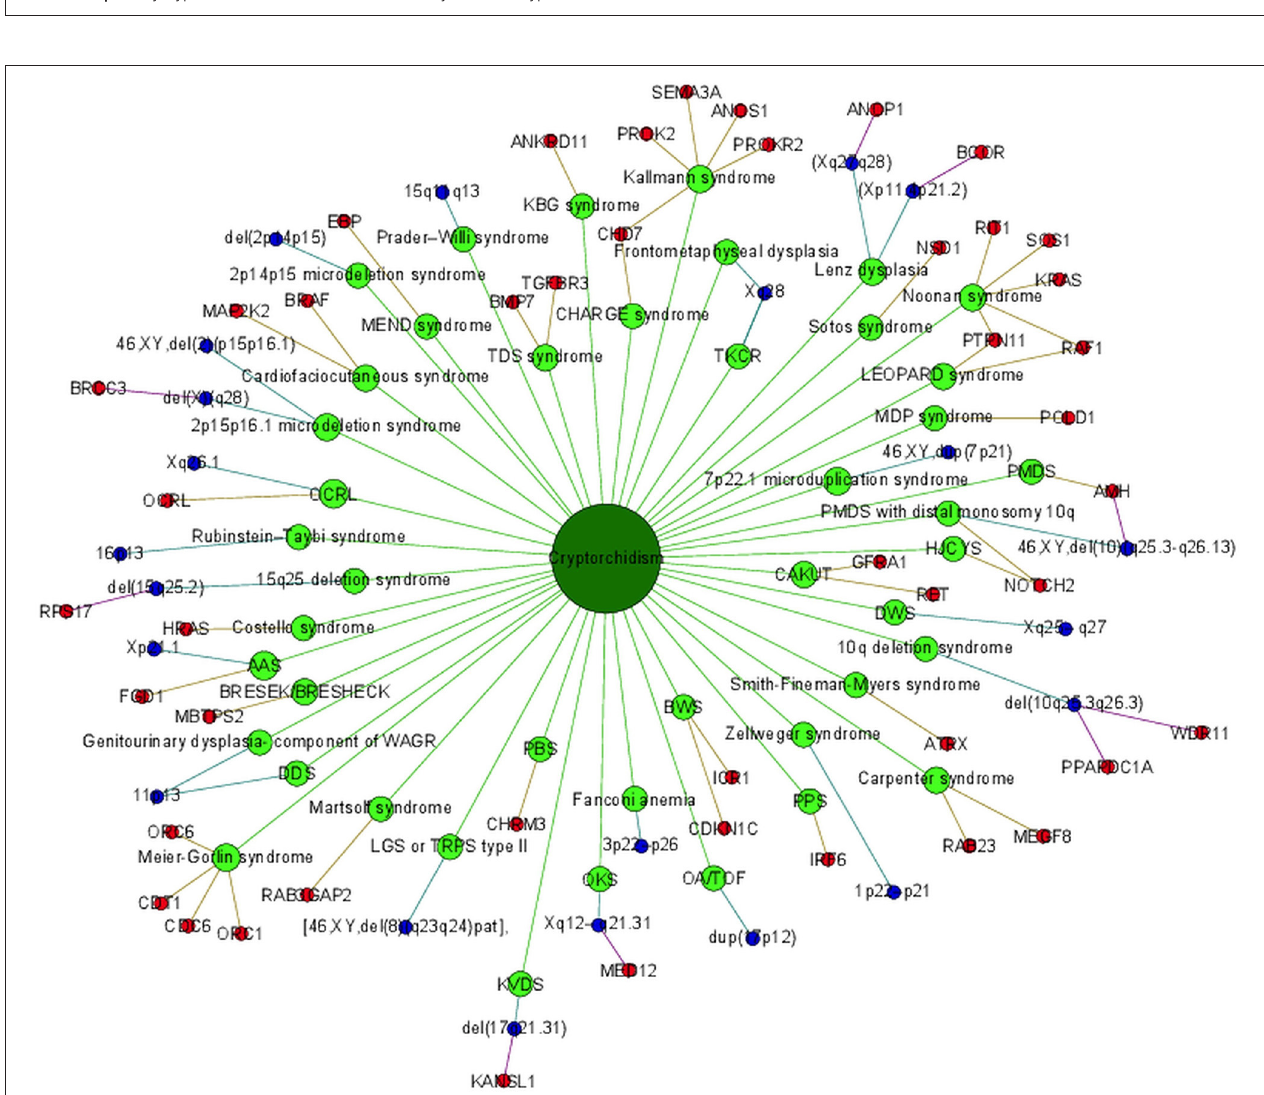
Frontiers in Endocrinology |